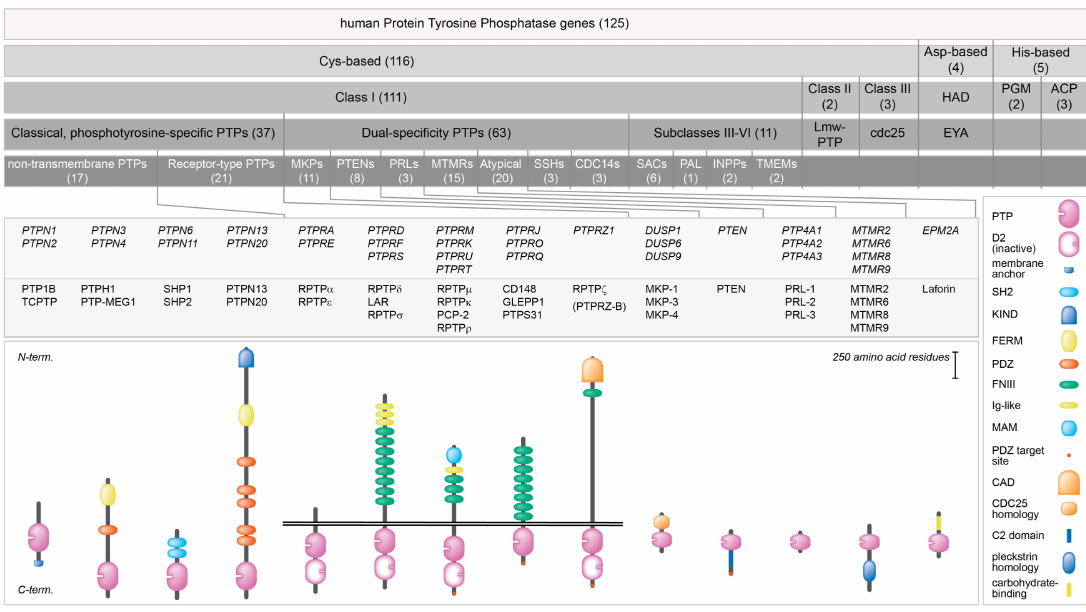
Figure 1. Classification and protein domain structure of PTPs discussed in this manuscript. Top five bars summarize the family’s (sub)class build-up, with number of genes indicated in between brackets. In the lower part, gene (italics) and protein names of representative PTPs, as well as the structures of fourteen PTP types are given. Horizontal twin black lines represent the plasma membrane. Protein domain representations are explained on the right. CAD, carbonic anhydrase-like; C2, protein kinase C conserved region; D2, inactive PTP domain; FERM, 4.1 protein-ezrin-radixin-moesin; FNIII, Fibronectin type three; Ig-like, Immunoglobulin-like; KIND, kinase non-catalytic C-lobe; MAM, meprin, A-5 protein, and RPTP-mu; PDZ, postsynaptic density-95/discs large/ZO1 homology; PTP, catalytic domain; SH2, Src Homology 2. Based on